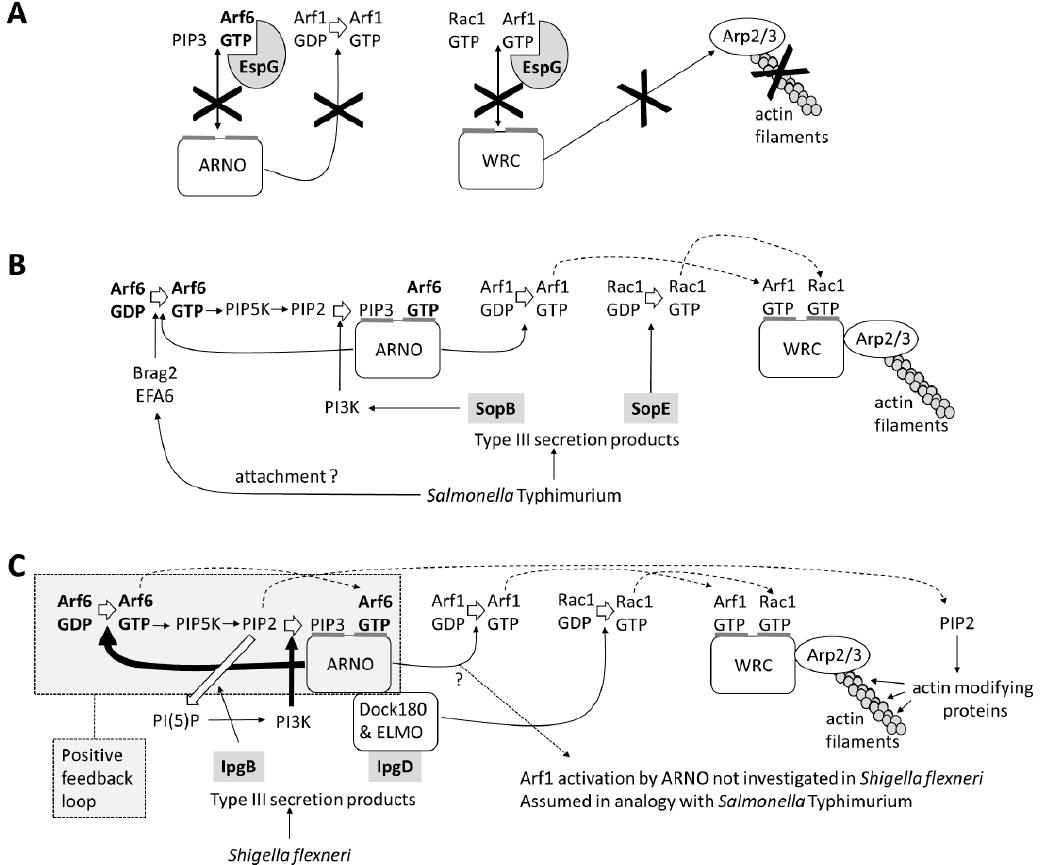
Figure 5. A subversion of Arf6 by bacteria: ( A ) EspG of enteropathogenic and enterohemorrhagic Escherichia coli (EHEC and EPEC) blocks the interactions of Arf6 and Arf1 to inhibit actin polymerization. Salmonella Typhimurium ( B ) and Shigella flexneri ( C ) use Arf6 and its guanine nucleotide exchange factors (GEF) ARNO to promote actin polymerization. Dark crosses indicate that the process is blocked by EspG. Dashed arrows indicate that the product is used in another step. Thick arrows indicate that the process is amplified by IpgB or the positive feedback loop.